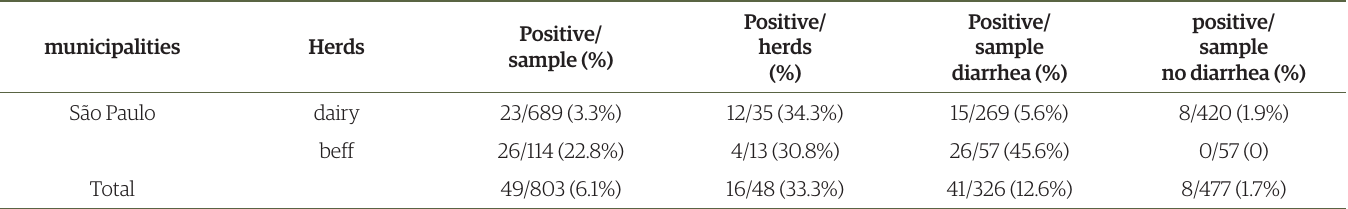
Table 2. General results, according to the type of fecal holding and consistency, of the PAGE technique for the detection of rotavirus in calves from the State of São Paulo, from 2006 to